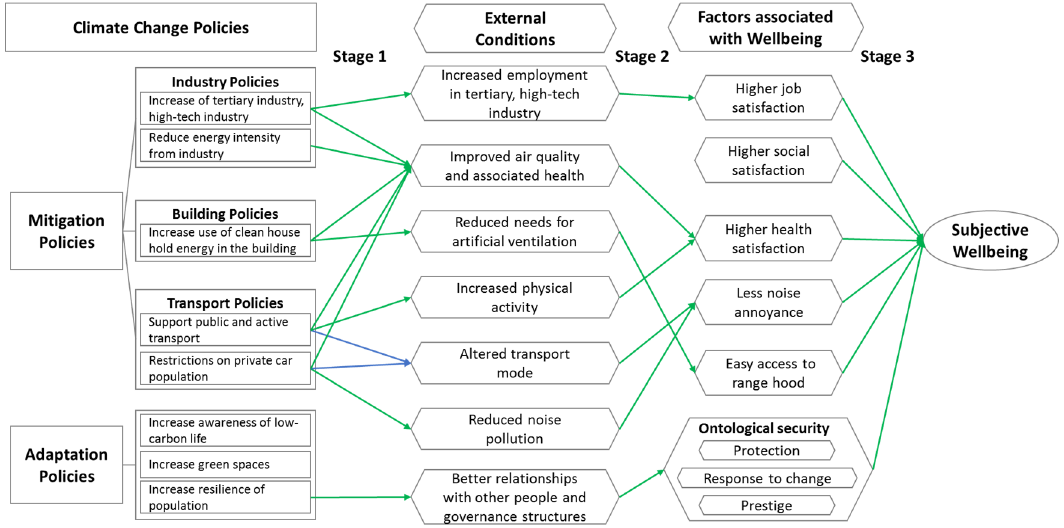
Figure 1. Putative pathways through which climate change policies might connect with wellbeing. Green lines indicate the positive relationships; Blue lines indicate neutral relationships.